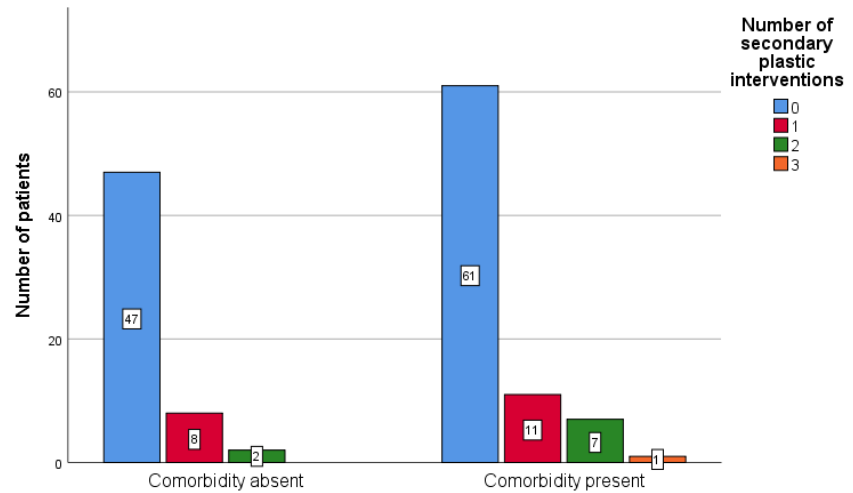
Figure 4. Frequency of secondary palatal surgical interventions based on the presence of comorbid-